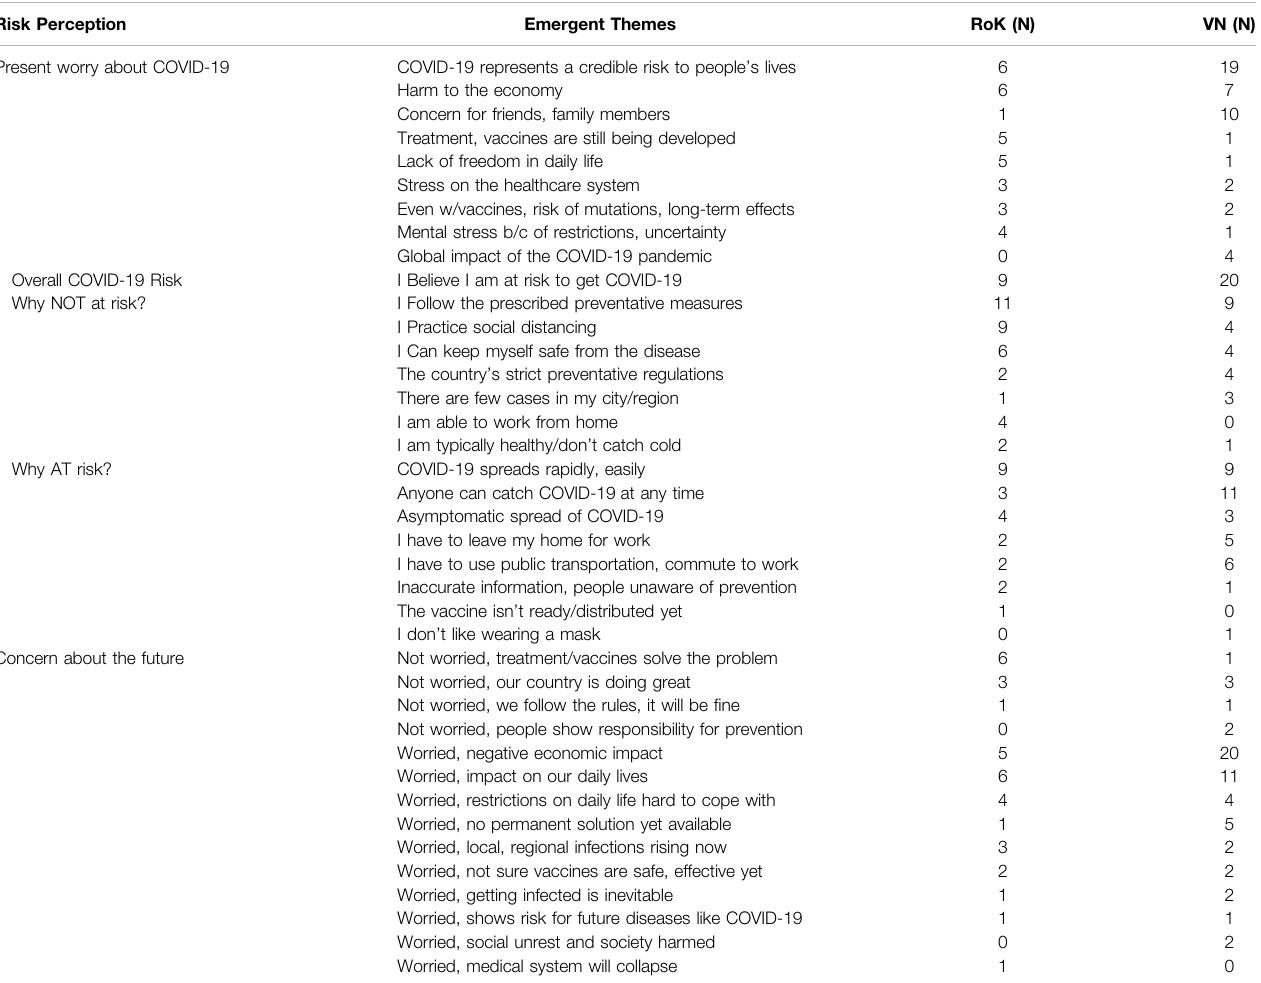
TABLE 3 | The in fl uence of country on reported risk and severity assessment of